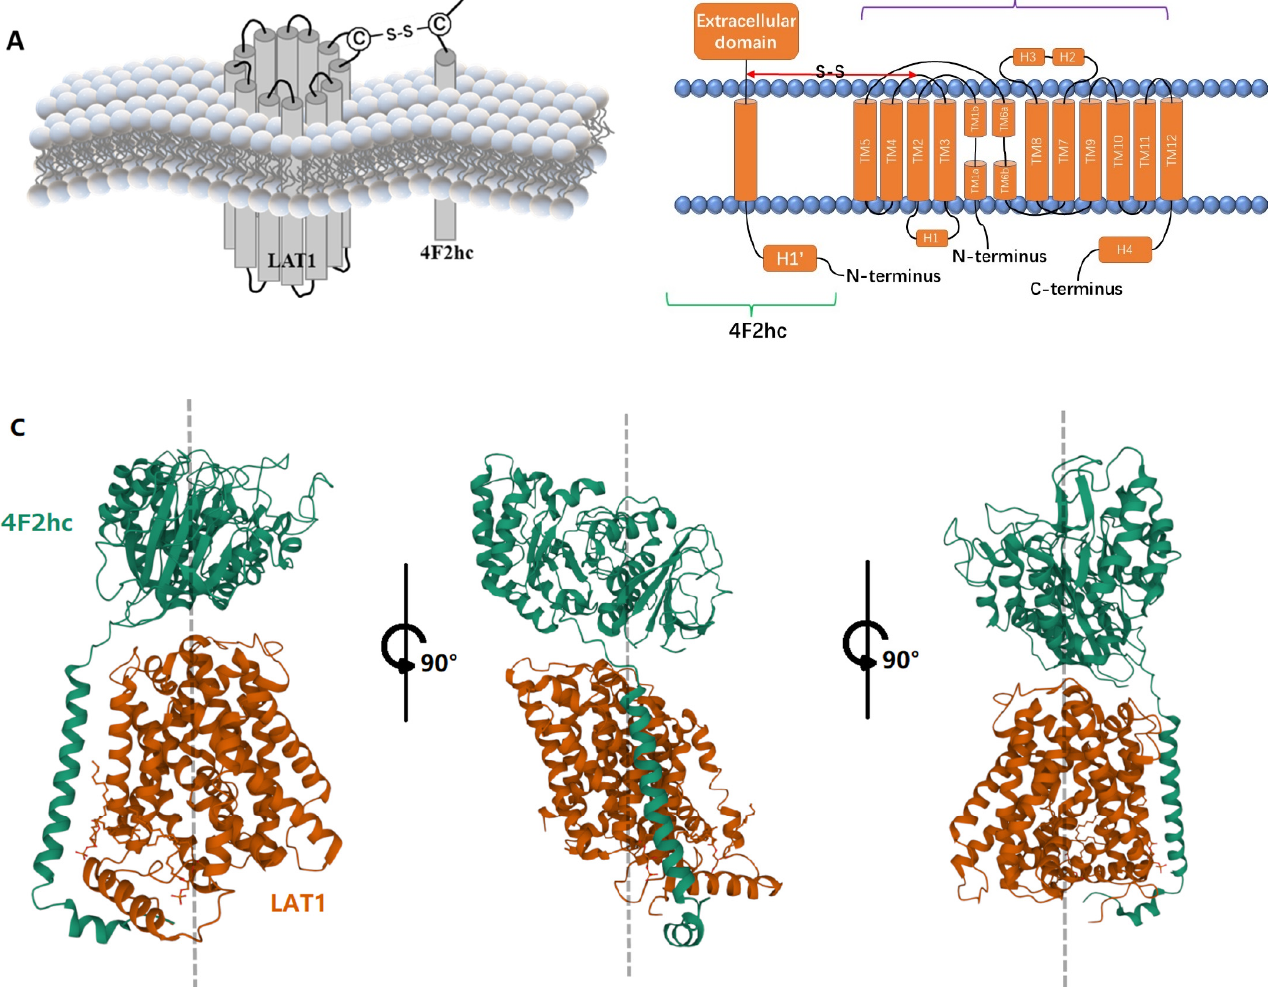
Figure 1. Structure of LAT1-4F2hc Complex: ( A ) Hypothetical model of the complex of LAT1 and 4F2hc; ( B ) LAT1 has 12 transmembrane units, while 4F2hc has only one. The two are covalently connected by disulfide bonds; ( C ) FIG1 ( C ) Images created using Mol*, the PDB ID: 6IRS, Structure of the human LAT1-4F2hc heteromeric amino acid transporter complex. [19], Mol* (D. Sehnal, S. Bittrich, M. Deshpande, R. Svobodov á , K. Berka, V. Bazgier, S. Velankar, S.K. Burley, J. Koˇca, A.S. Rose (2021) Mol* Viewer: modern web app for 3D visualization and analysis of large biomolecular structures. Nucleic Acids Research. doi: 10.1093/nar/gkab314 [21]), and RCSB PDB. According to the structure of LAT1-4F2hc heterodimeric amino acid transporter pro- tein complex, 4F2hc had only one transmembrane helix that seemed to be unable to form a transmembrane transporter pore. It shows that 4F2hc has a lack of amino acid transport structure. That is the reason why past studies have reported that LAT1 is the only sole